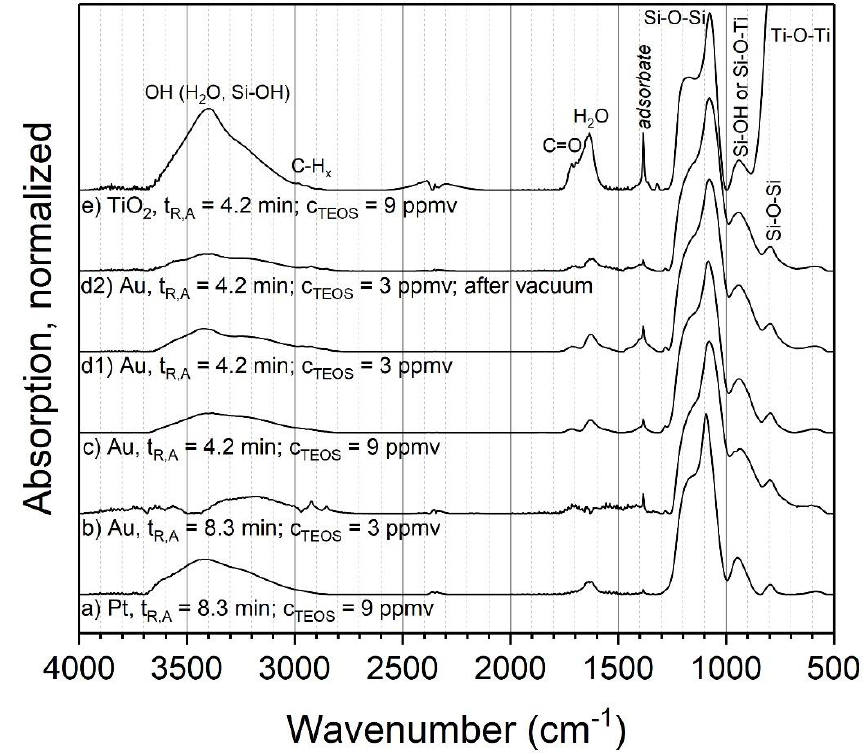
Figure 3. FTIR spectra of coatings with TEOS as the precursor at ambient temperature. t R,A :aerosol residence time, C TEOS :initial TEOS concentration. The spectrum c was published before and is reproduced with permission from the copyright holder Wiley-VCH Verlag GmbH & Co. KGaA [14].